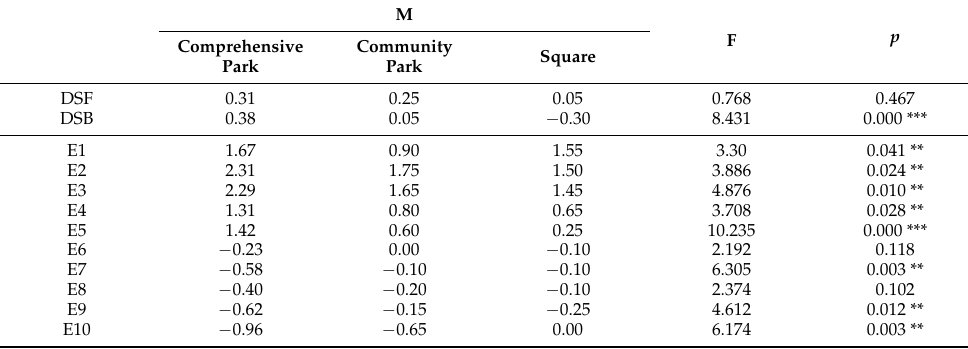
Table 5. Differences in restorative effects of different park